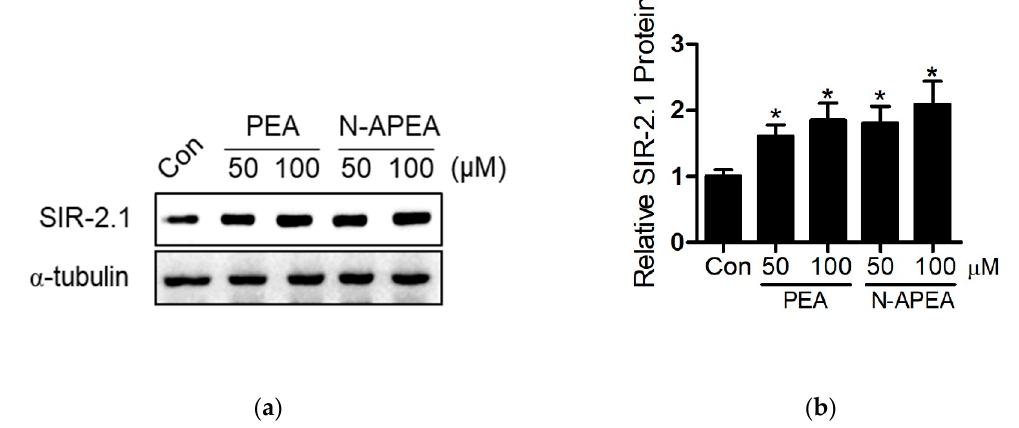
Figure 5. Western blot analysis of SIR-2.1 protein expression in wild-type N2 C. elegans upon treatment with PEA or N-APEA at 50 and 100 µ M. ( a ) Representative western blot images. ( b ) Quantitative analysis for relative expression of SIR-2.1. The results represent the mean ± SEM of three independent experiments. Significance was determined by one-way ANOVA (* p < 0.05).